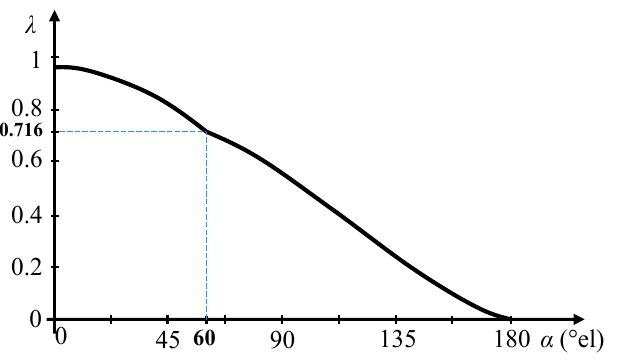
Figure 9. Power factor λ vs. firing angle α of a three-phase semiconverter with inductive load.